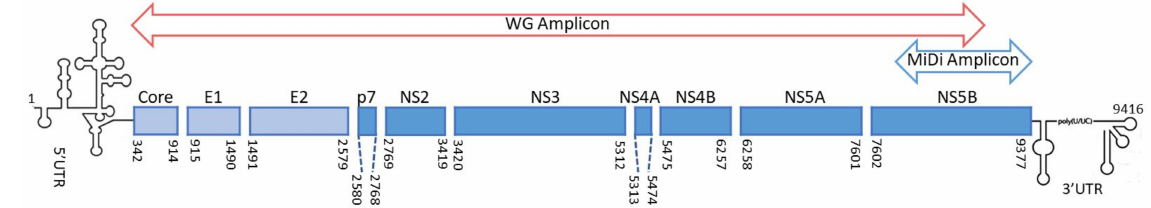
Figure 1. HCV genome map. A schematic representation of the HCV genome depicting coverage of the genotype- independent, near-whole genome sequencing method wherein the genome is amplified in two fragments then sequenced in